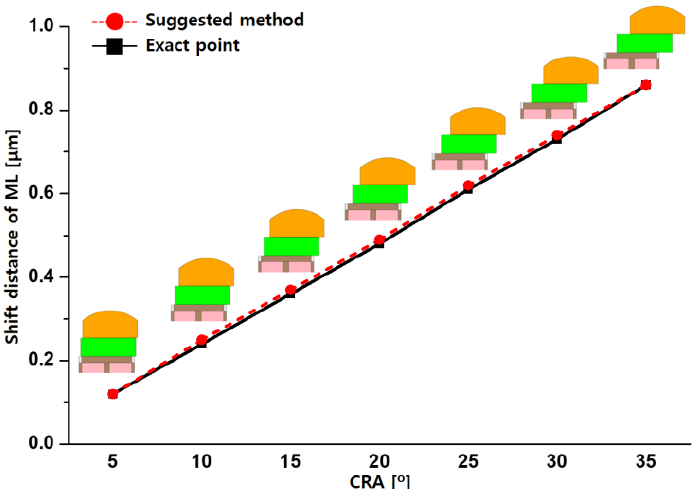
Figure 6. Comparison of simulation and calculation results with the changed CRA from 5° to 35° on the same condition of pixel pitch, microlens (ML) height, and ROC at CRA 35°. Simulation results were supplemented and visualized by beam profiles. Figure 7 shows the simulated 3D structure and beam profile of a 1.0 and 0.6 µ m size pixel that was optically aligned by the proposed method at CRA 35 ◦ . The simulated pixels have optimized microlenses, as in Figure 2. Figure 7a shows the simulated 1.0 µ m pixel structure with quad CF and 2 × 2 ML having a height of 1.4 µ m and a ROC of 1.4 µ m. The optical stacks, such as the microlens and CF, were aligned by using Equation (1). As a simulation result with calculated shift distance, the beam profile indicates even distributed oblique incident light to four pixels under the quad CF. In the simulation, the optical stacks were aligned by using the suggested method in order to guide incident light to adjacent pixels under the shared CF from in-pixel DTI. Therefore, the effectiveness of the suggested method could be confirmed in the optical path of the beam profile. Figure 7b shows the 2 × 2 ML pixel having a pixel pitch of 0.6 µ m with a quad CF array. The microlens is optimized by the height of 1.0 µ m and ROC of 0.9 µ m. As a result, the beam profile shows the incident light separated into four pixels under the shared CF, as shown in Figure 7a. Therefore, the optical stack was almost precisely aligned from the calculation with the suggested method, showing its